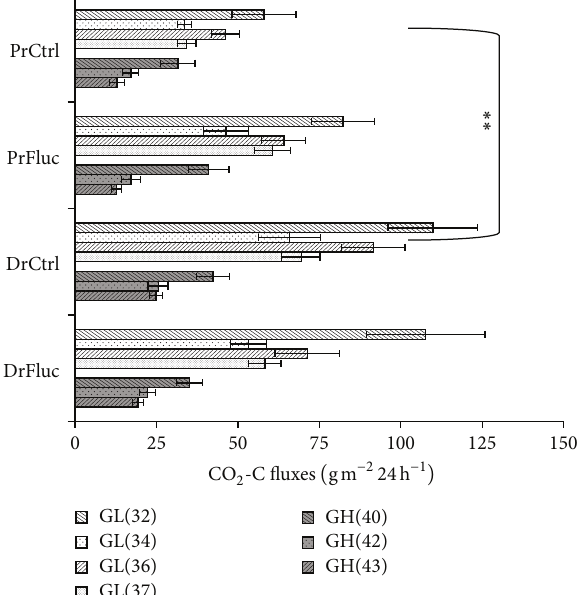
Figure 6: Mean ( ± SE) CO 2 -C fluxes in different experimental groups at phases GL(32–37) and phases GH(40–43). 𝑁 = 5 except in DrCtrl at phase GL(37), in DrFluc at phase GH(40), and in PrCtrl and PrFluc at phase GH(43), where 𝑛 = 4 . Significant difference between the experiment groups is indicated with asterisks ( ∗∗ 𝑃 <